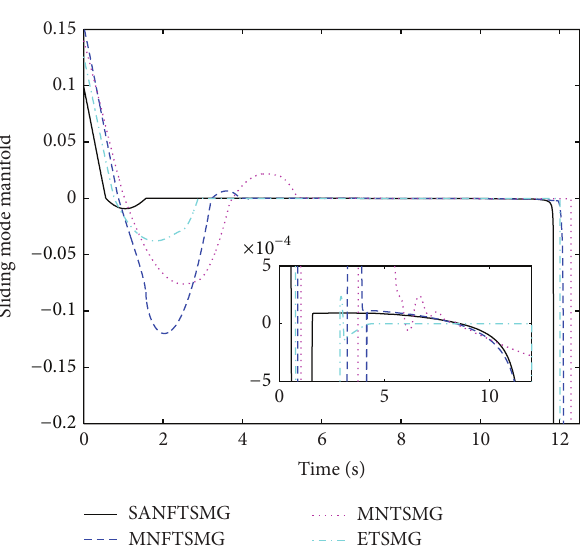
Figure 28: Trajectories of missile and target (Case 3).